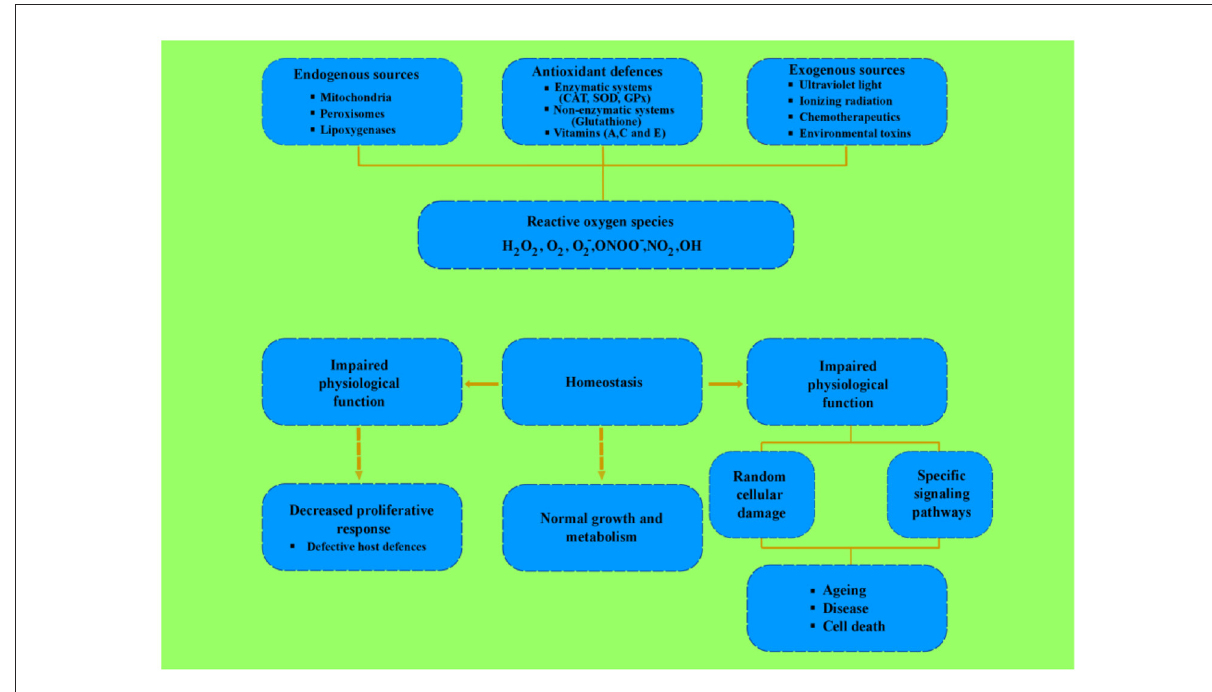
FIGURE6 Endogenous and exogenous sources of ROS, antioxidant defenses, and biological effects that depends on ROS